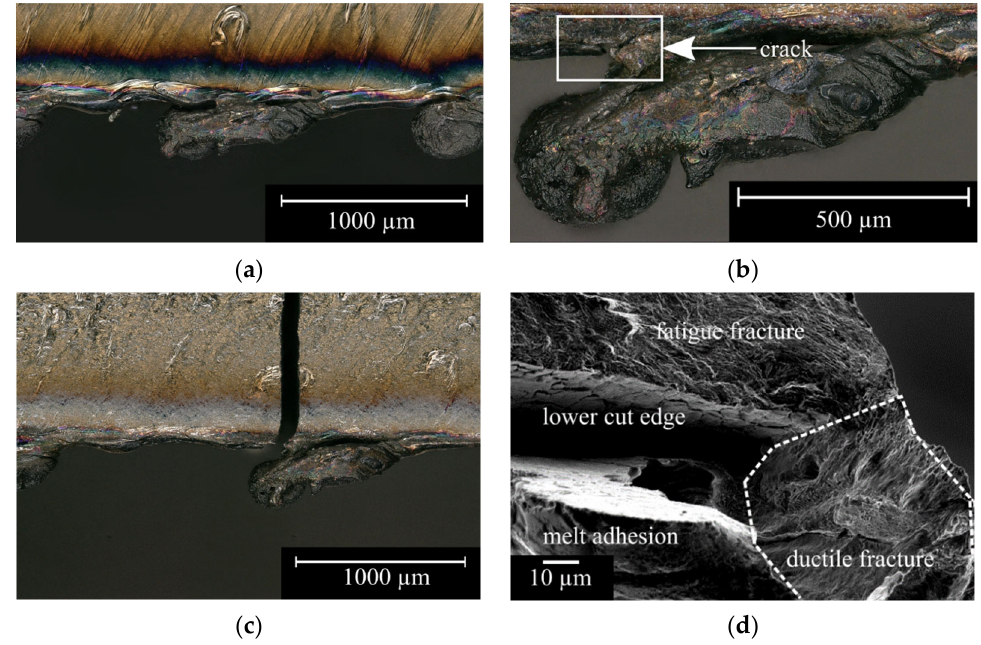
Figure 9. Crack initiation origin of a representative specimen with large droplets in the states ( a ) before pre-deformation and ( b ) after pre-deformation. ( c ) The fatigue crack origin starting from the dross. ( d ) SEM image of the crack initiation site with di ff erent fracture surface characteristics.